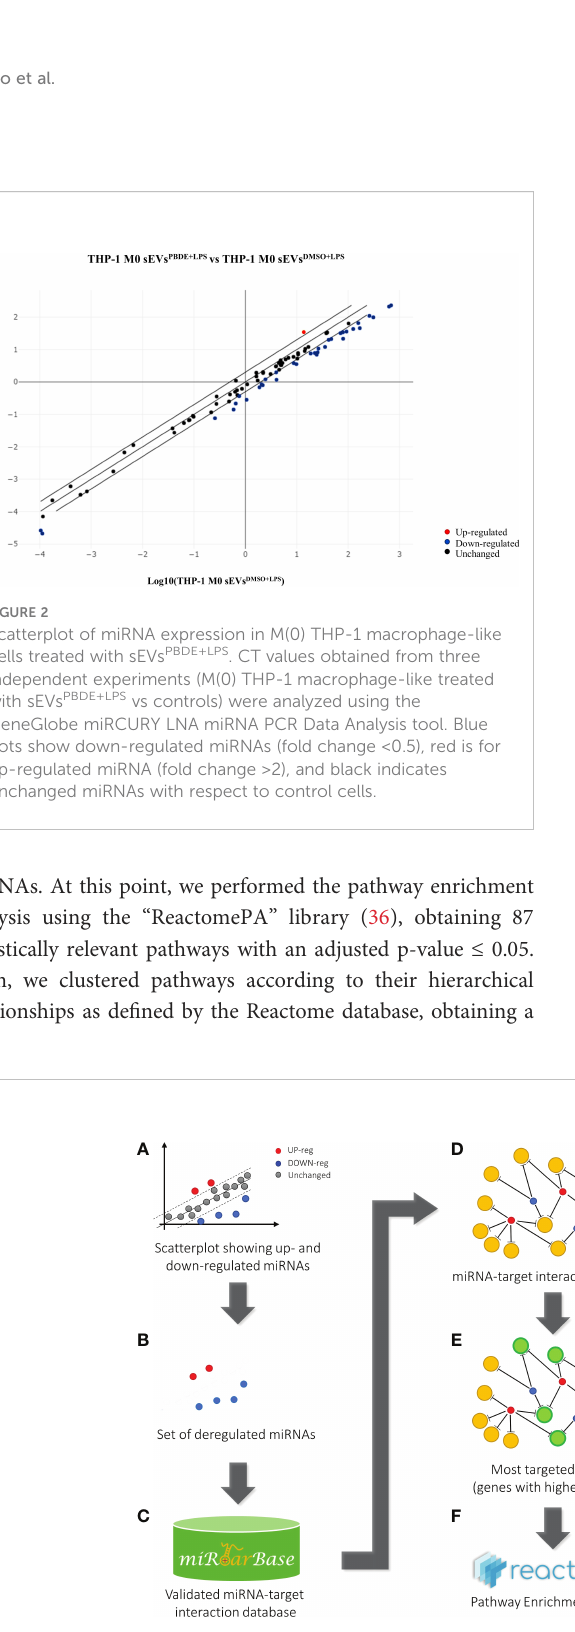
FIGURE 3 Bioinformatic work fl ow for pathway enrichment analysis work fl ow. Starting from the scatterplot showing the analyzed miRNA expressions (A) , the set of dysregulated miRNAs (blue and red points) was considered (B) to get all the validated miRNA-target pairs from the miRTarBase database (C) . At this point, the network containing all the miRNA-target interactions was de fi ned (D) . Then, the most targeted genes (green circles), i.e., genes targeted by at least a signi fi cant number of miRNAs (genes with a higher degree in the network) (E) , were selected for the pathway enrichment analysis according to the Reactome repository (F) . Finally, the most statistically signi fi cant pathways were identi fi ed (G) and clustered according to hierarchical relationships de fi ned in the Reactome database. The representative pathways of each cluster (here bounded by colored curves) are given as a result (H)